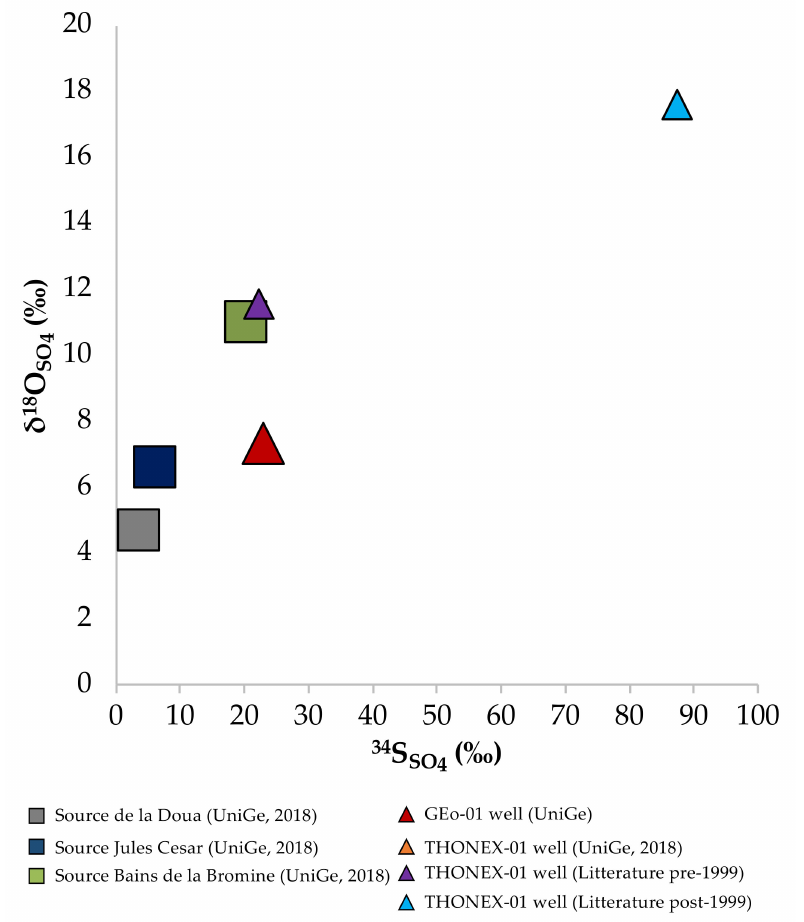
Figure 8. Sulfur isotopes in